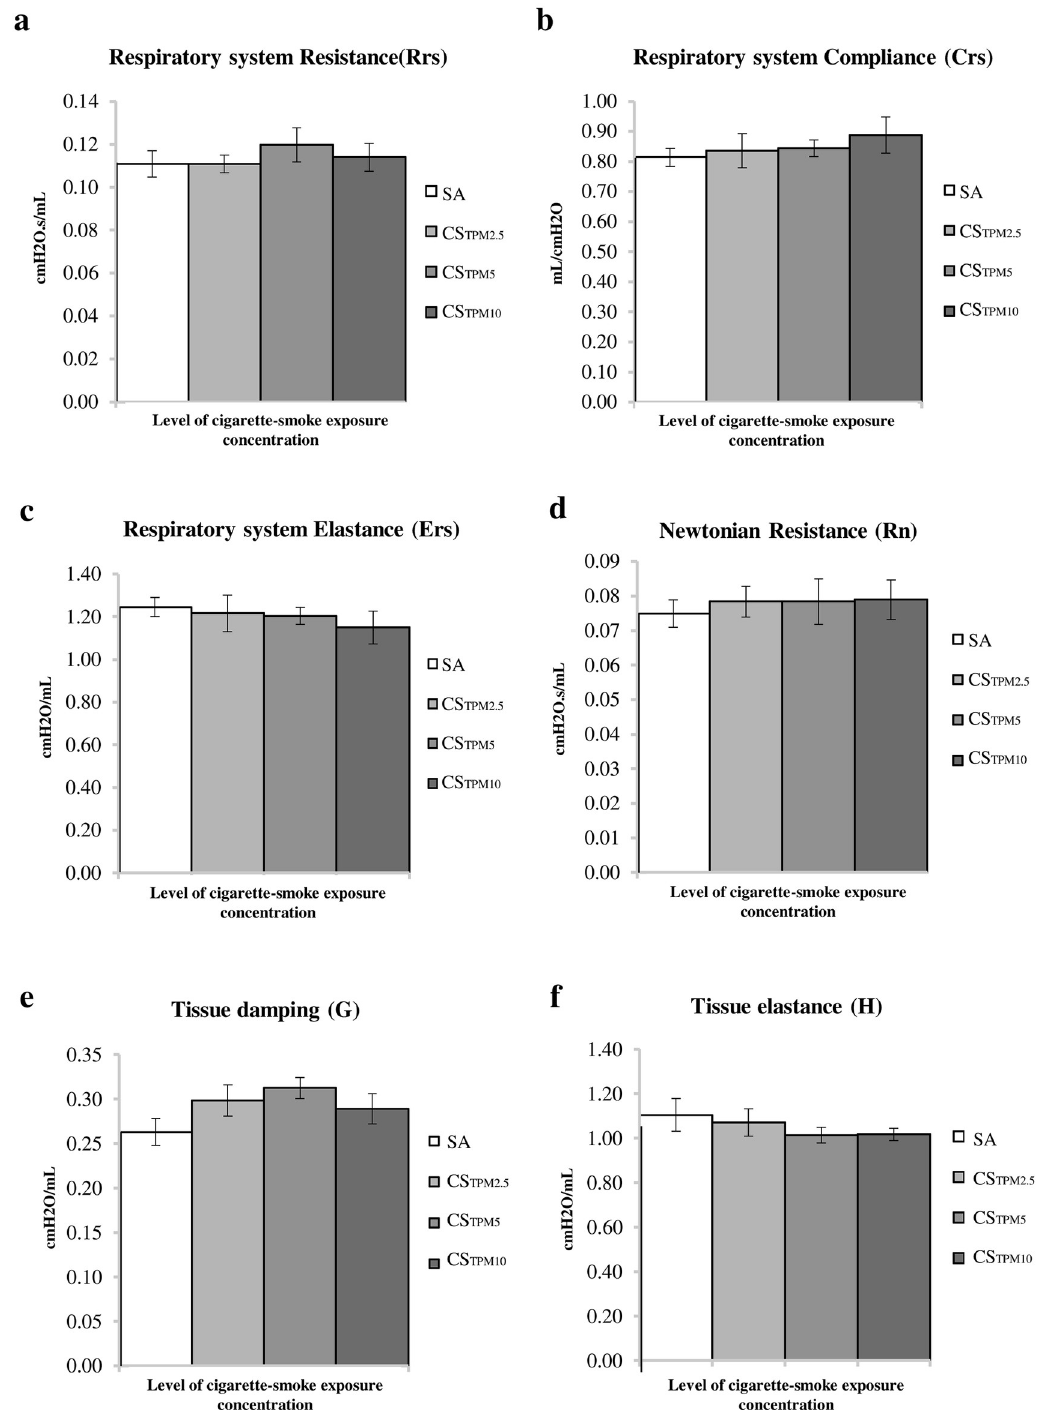
Fig 1. Various parameters of lung functions upon acute cigarette smoke exposure. Histogram summarizing the (a) respiratory system resistance, (b) respiratory system compliance, (c) respiratory system elastance, (d) newtonian resistance, (e) tissue damping and (f) tissue elastance (H) of the lung function parameter from SA group and CS group. All data are presented as mean ± SEM.